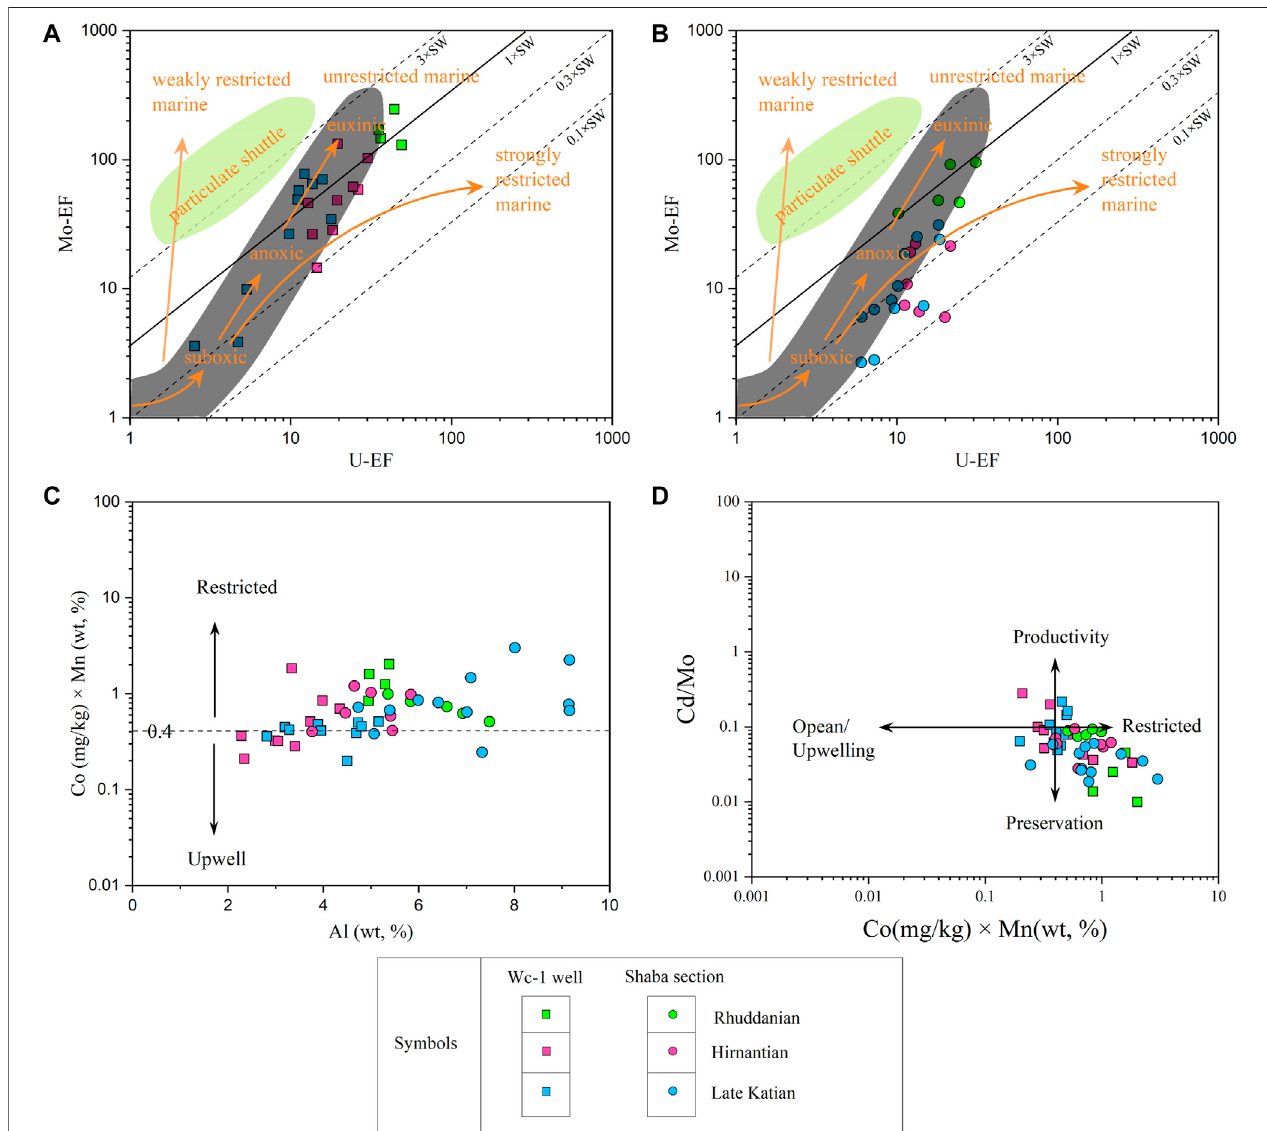
FIGURE6| Crossplotsof (A) AlversusCo × Mnand (B) Co × MnversusCd/MoforWc-1wellandShabasection.Enrichmentfactors(EF)ofMoversusUin (C) Wc- 1welland (D) Shabasection.ThesolidlineshowstheMo/Umolarratiosof1 × seawatervalue(SW)anddottedlinesindicate0.1 × SW,0.3 × SW,and3 × SW(Algeoand Tribovillard,